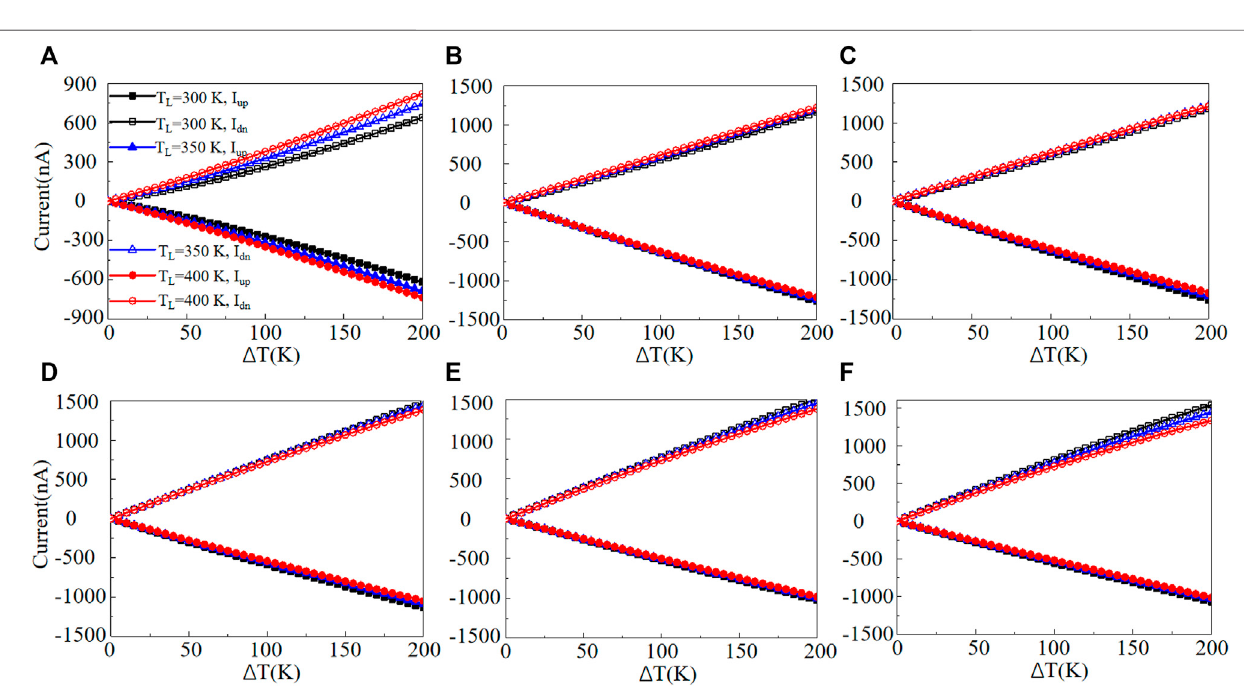
Frontiers in Physics |